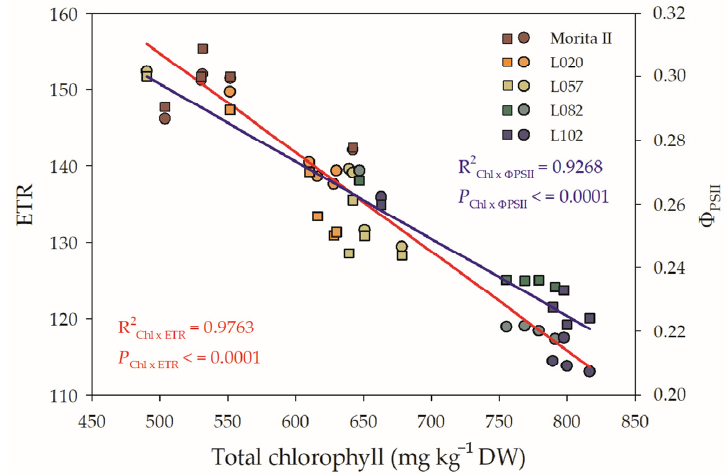
Figure 7. Relationship between total chlorophyll (Chl total ) and electron transport rate (ETR; left y axis) and Chl total and Φ PSII (ETR; right y axis) evaluated in genotypes of Stevia rebaudiana (Morita II, L020, L057, L082, and L102) under land conditions in the complete absence of any plant stress. The regression R 2 and p value are shown.